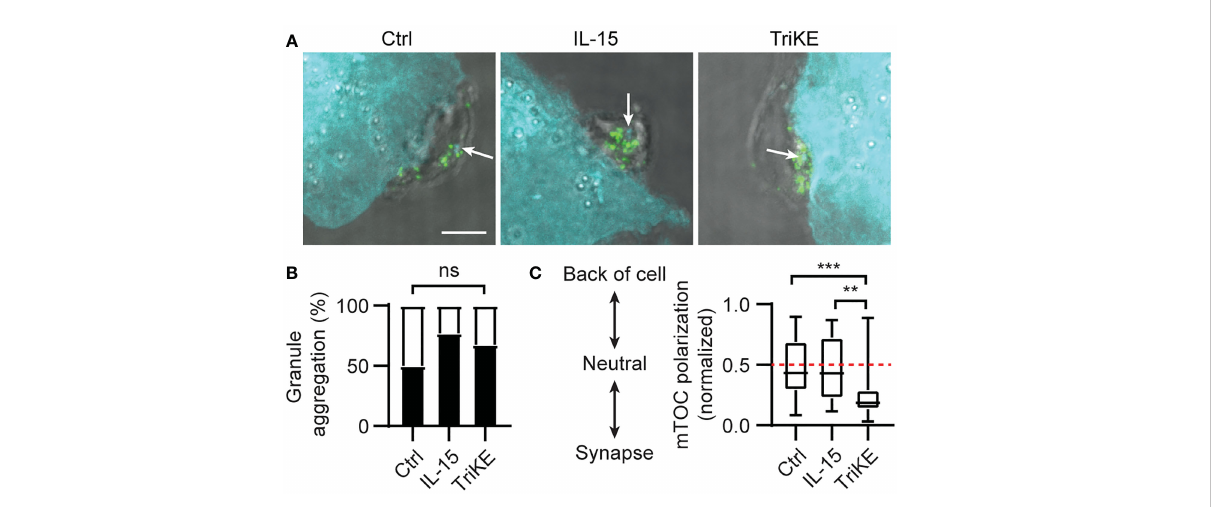
FIGURE 4 Cam1615SS1 promotes mTOC polarization. (A – C) NK cells (unlabelled) were incubated with the indicated drugs and A549 (CellTrace Far Red; cyan) for 5 mins, before being fi xed and stained for the microtubule organizing center (mTOC; cyan in NK cells and white arrows) and perforin (green). Representative maximum intensity projections through each cell are shown (A) with scale bar 5 m m (3 independent donors, at least 27 cells/ condition). (B) Quanti fi cation of granule aggregation around the mTOC across all images; each cell was given a binary score for aggregated (1) or dispersed (0). Fisher Exact Test. (C) Quanti fi cation of the distance of the mTOC to the synapse as a ratio of the cell width. Kruskal-Wallis test with Dunn ’ s multiple comparisons. ** p<0.01, ***